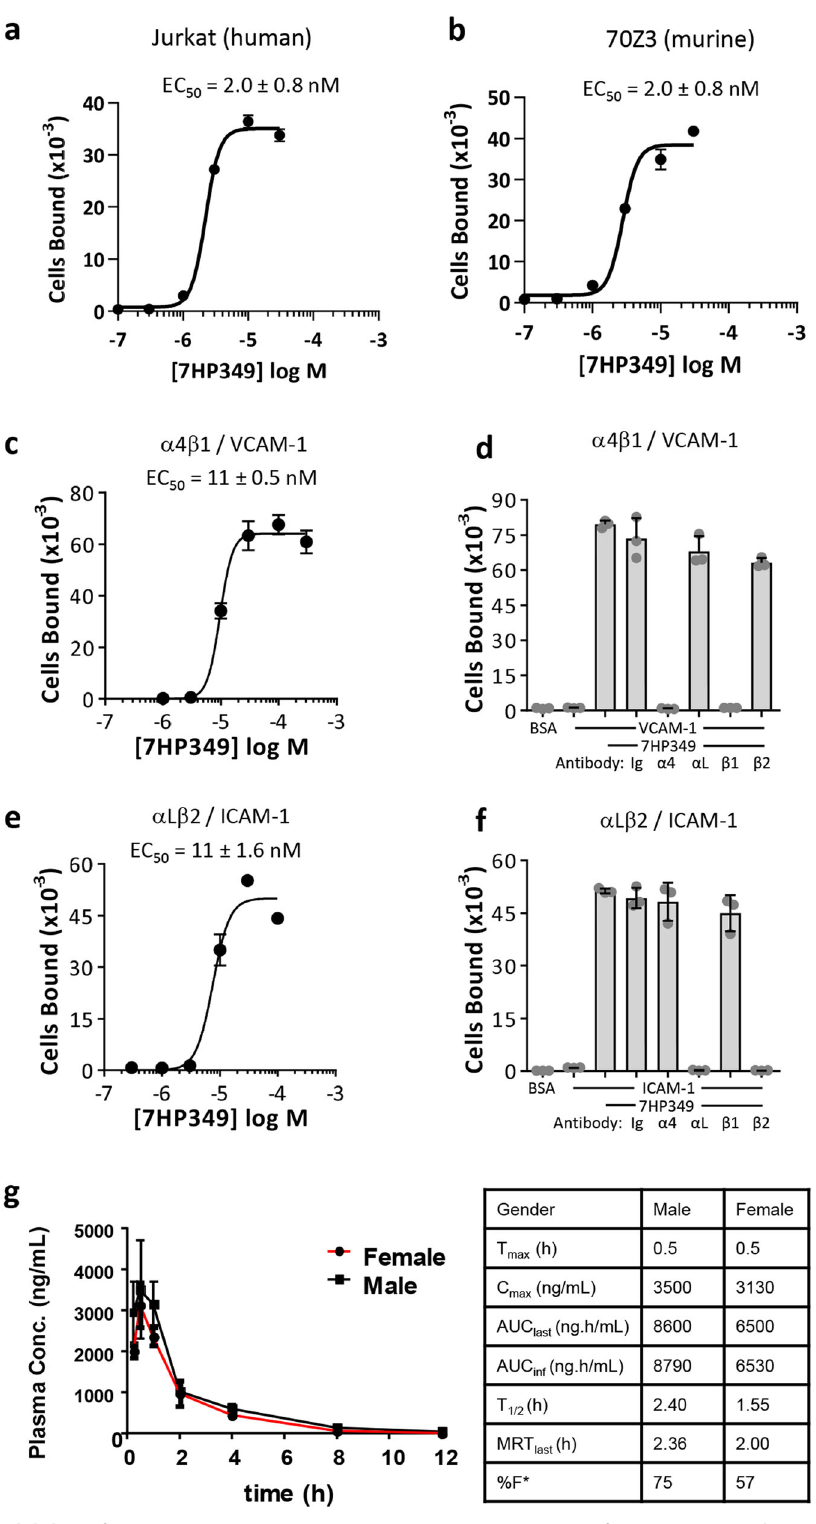
Fig. 1 Activity and bioavailability of integrin activator 7HP349. a Dose-response curves of 7HP349 against human ( a ) and mouse ( b ) α 4 β 1. The compound activates cell adhesion to VCAM-1 ( c , d ) and ICAM-1 ( e , f ) in an α 4 β 1 and α L β 2 dependent fashion, respectively. All adhesion assays were performed at least three times, and data are presented as mean ± SD from triplicate determinations. One representative experiment is shown. Mean EC 50 values determined from 3 independent experiments are shown either in the absence ( a , b ) or presence ( c , e ) of 50% serum. All function-blocking mAbs and IgG controls were used at 10 µg/mL. g Male and female C57BL/6 mice were dosed intraperitoneally (40 mg/kg), and blood samples were collected at the indicated time points ( n = 3 mice/time point). The plasma samples were analyzed for the quanti fi cation of 7HP349 using a fi t-for-purpose LC-MS/MS method and PK parameters calculated using non-compartmental analysis. Data are plotted as mean values ± standard error mean